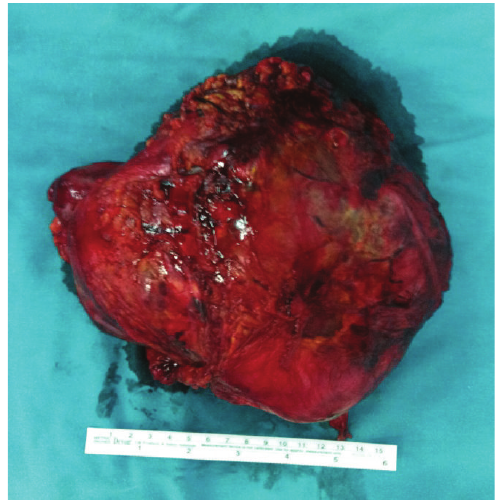
Figure 5: Macroscopic view of adrenal